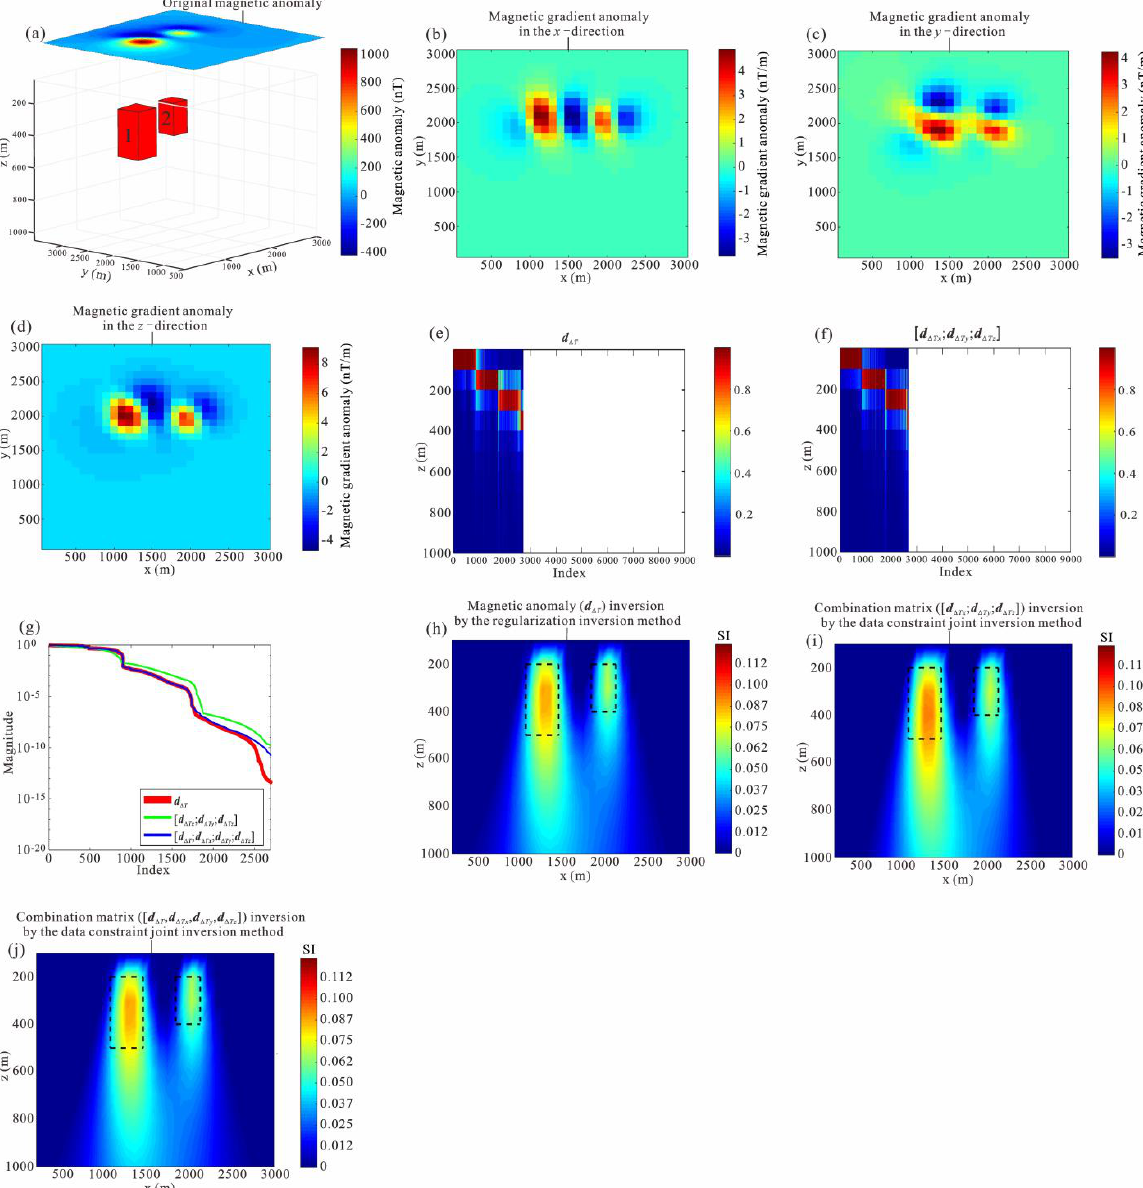
(cid:104) (cid:105) d ∆ T ; d ∆ T ; d ∆ T ) x y z